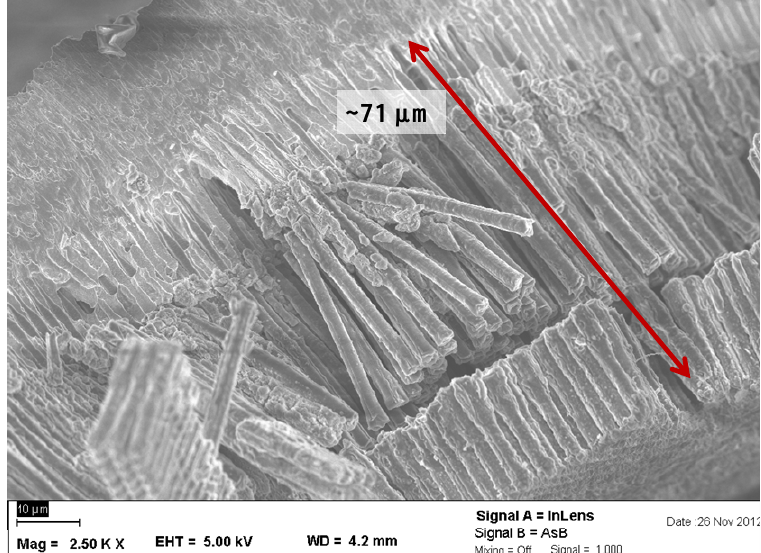
Figure 3. Scanning electron microscope ( SEM) micrograph of the anodes after the second lithiation cycle. The wires were broken during the preparation of the sample for SEM (a cut in cross section), as confirmed with other micrographs, where the wires behind the cut fronts were complete (see Figure S1). The length of the wires is nearly the same as in the not lithiated